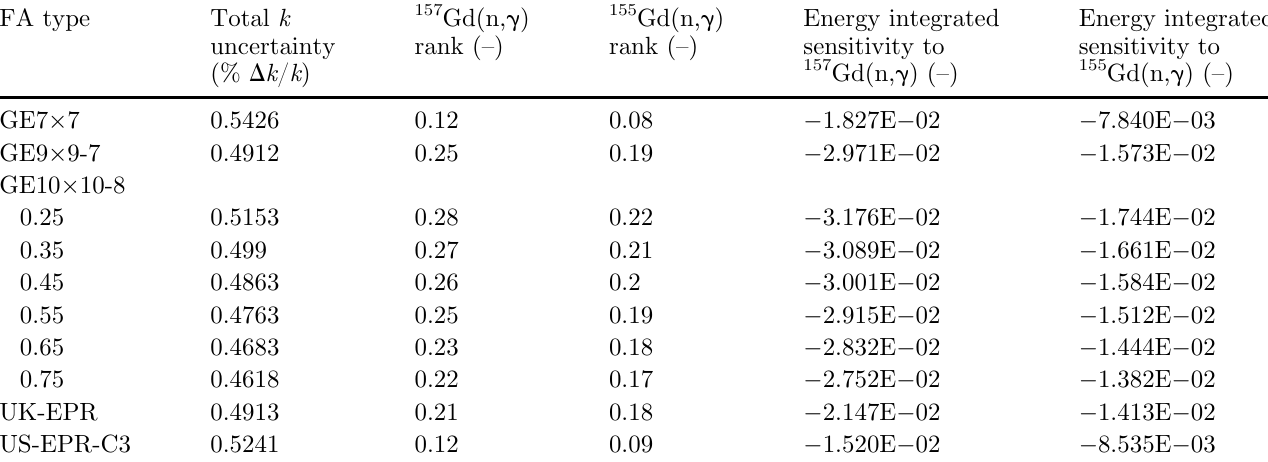
Table 7. Energy integrated sensitivity and uncertainty values for the FAs